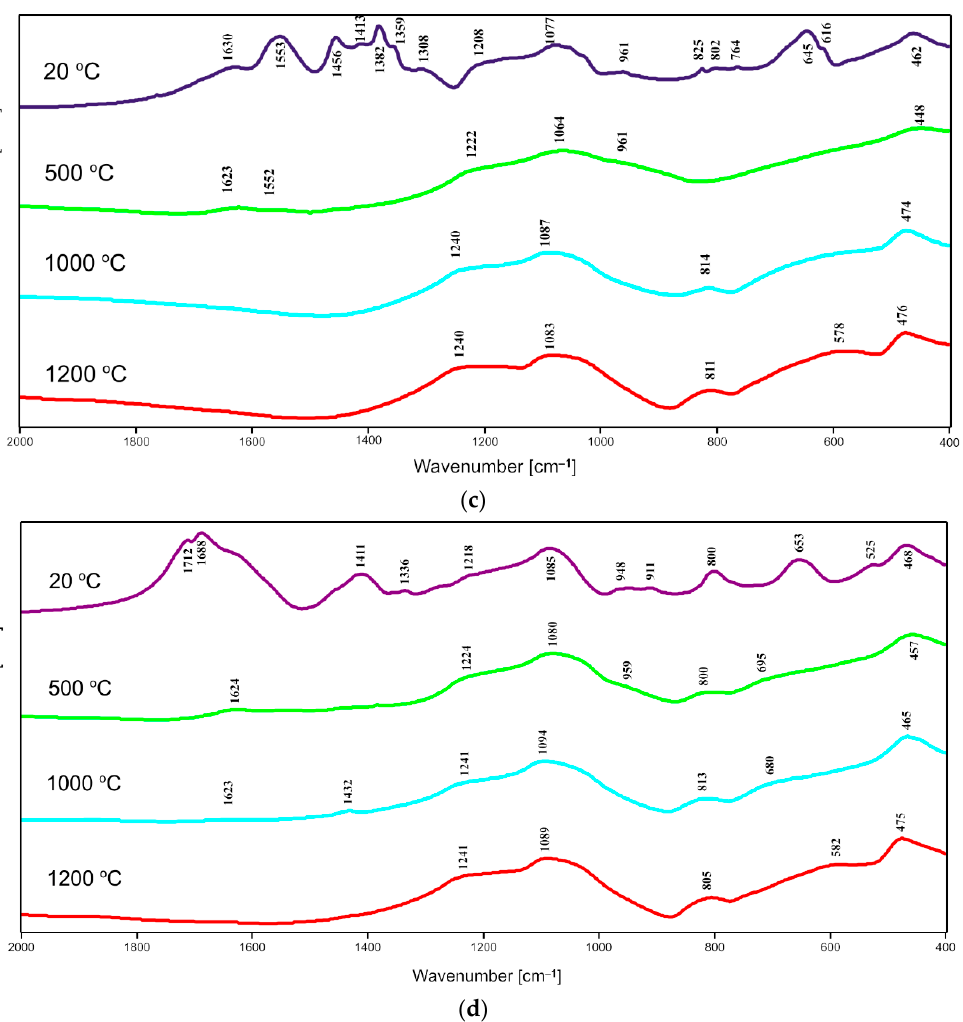
Figure 6. FTIR spectra of: ( a ) 1C sample; ( b ) 2C sample; ( c ) 3C sample and ( d ) 4C sample. All samples were synthesized using zirconium (IV) acetate and annealed at 500 °C, 1000 °C and 1200 °C in air.